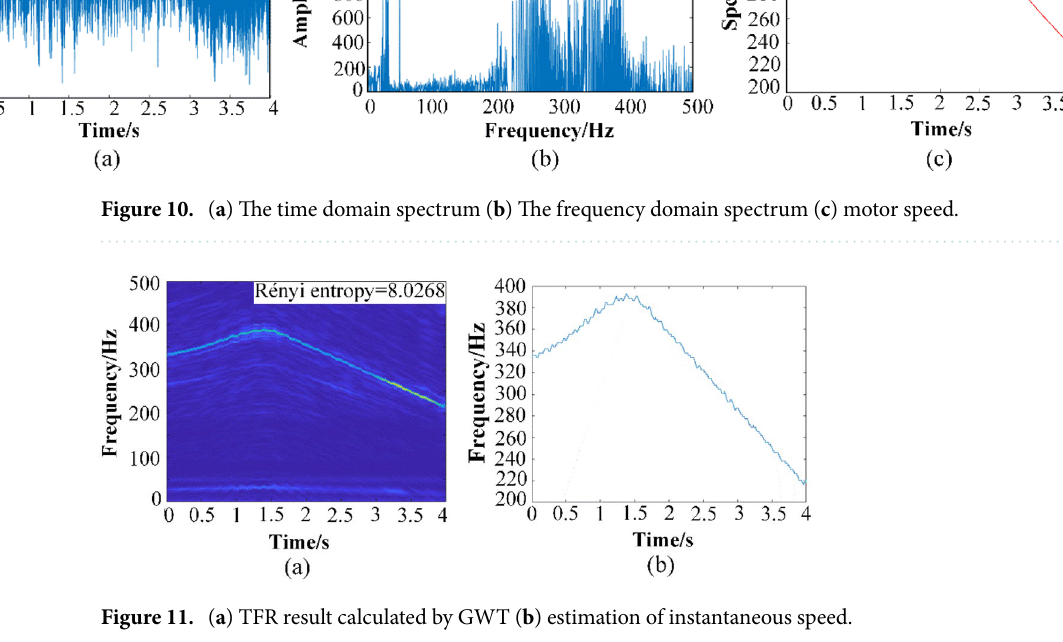
Figure 11. ( a ) TFR result calculated by GWT ( b ) estimation of instantaneous speed.